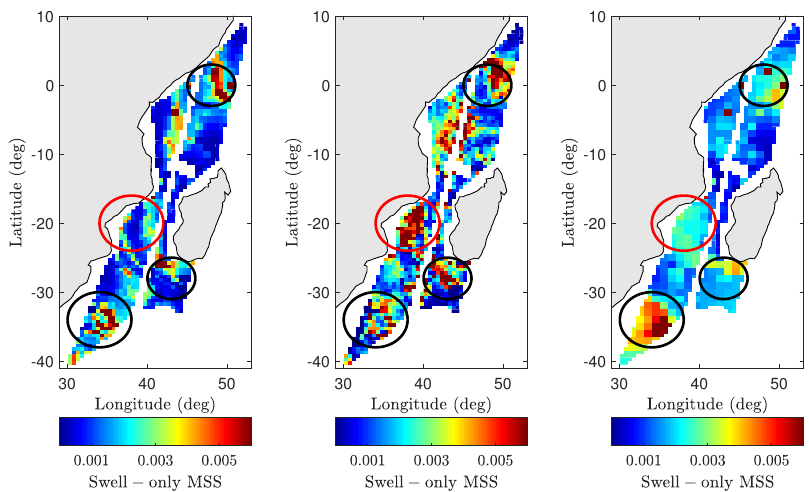
Figure 20. Swell retrieval comparisons for SMAP pass 02260_D. Plots from ( left ) to ( right ) show retrieved excess MSS based on the wind + swell model, retrieved excess MSS based on SMAP data, and excess MSS computed using 2D approximated spectra, respectively. Excess MSS retrievals are based on excess NRCS results shown in Figure 16. See text for more